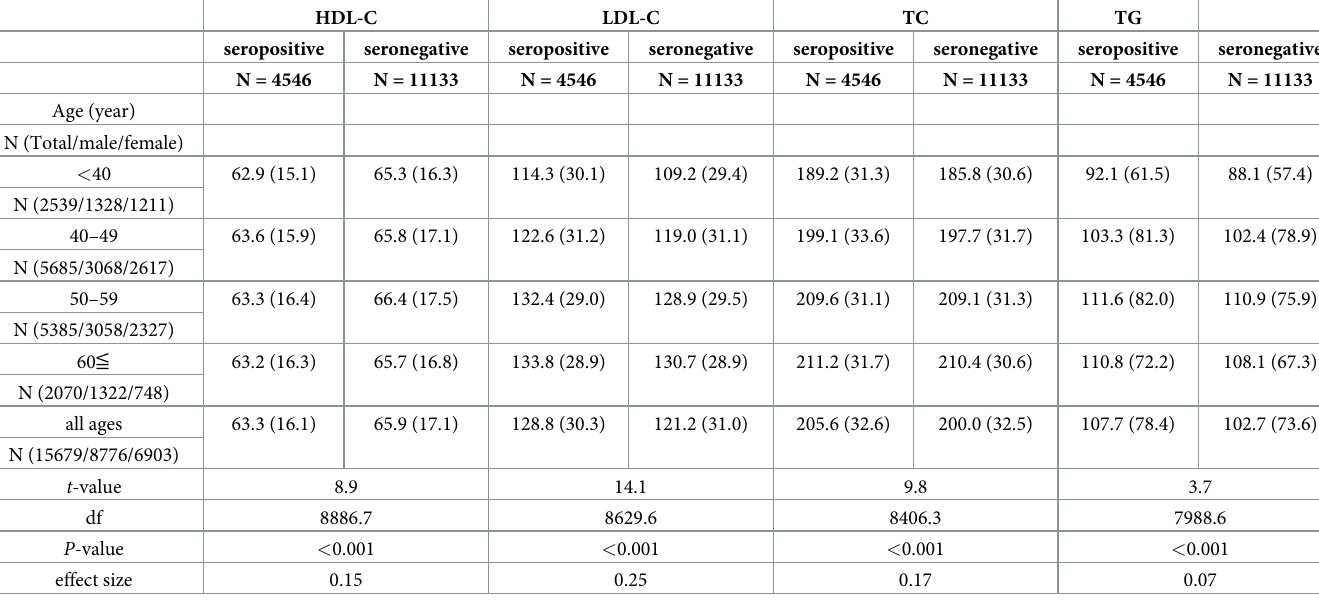
Table 1. Characteristics of serum HDL-C, LDL-C, TC, and TG categorized on the basis of the status of serum Helicobacter pylori IgG antibody and age groups.